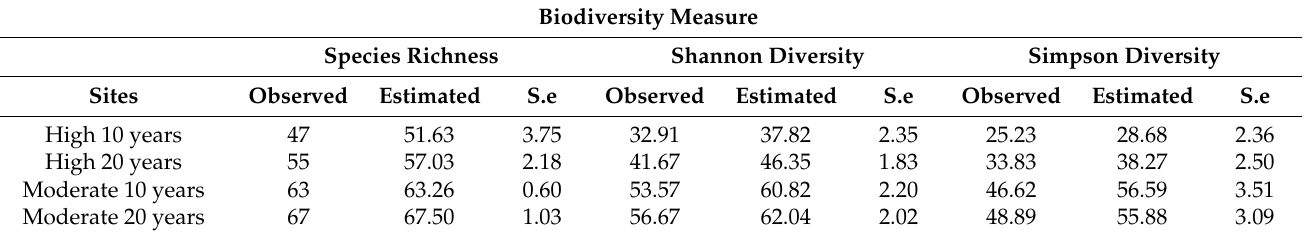
Table 2. Species biodiversity measure between sites under different fallow regimes.